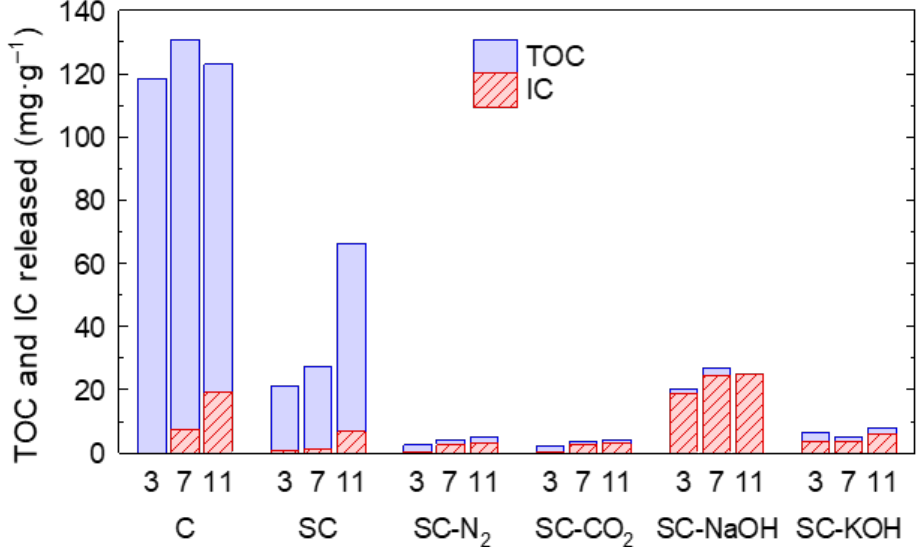
Figure 4. Organic and inorganic leaching of the char from plastic pyrolysis before and after activation at different pH values. Experimental conditions: C solid = 1 g · L − 1 ; time contact, 24 h.